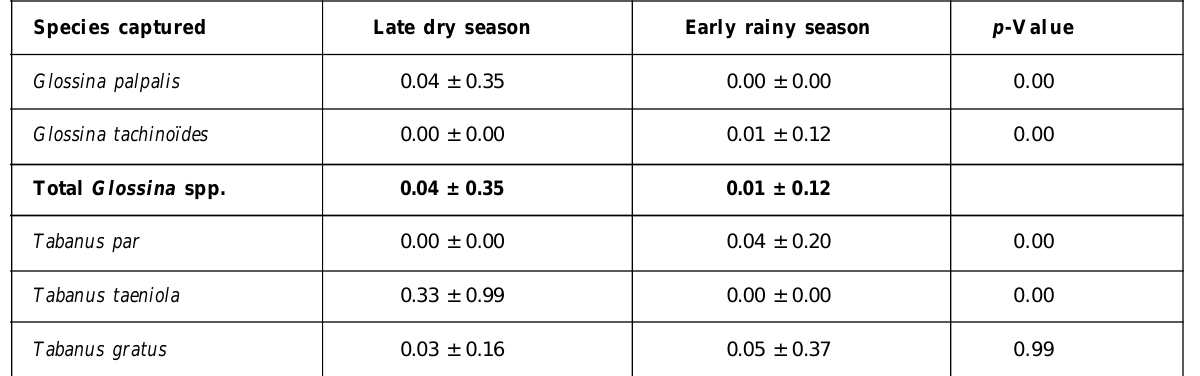
Table 4: Fly-vector apparent densities with